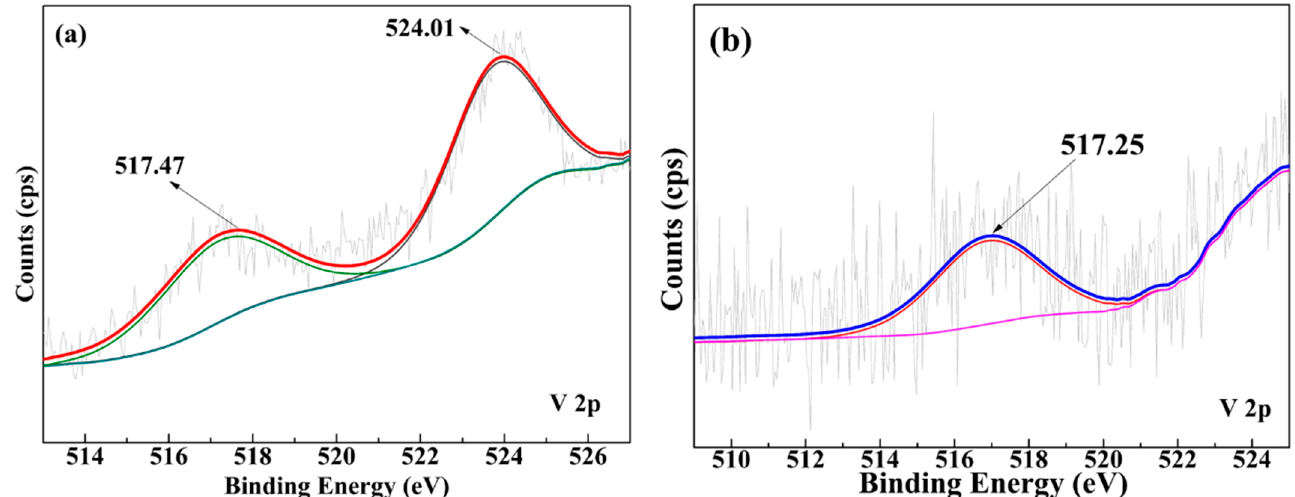
Figure 13. The XPS analysis of samples obtained at pH value of 0.6: ( a ) Na 2 SO 4 ; ( b ) K 2 SO 4 .